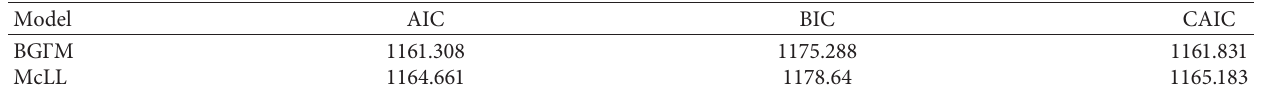
Table 6: The corresponding AIC, BIC, and CAIC on real data